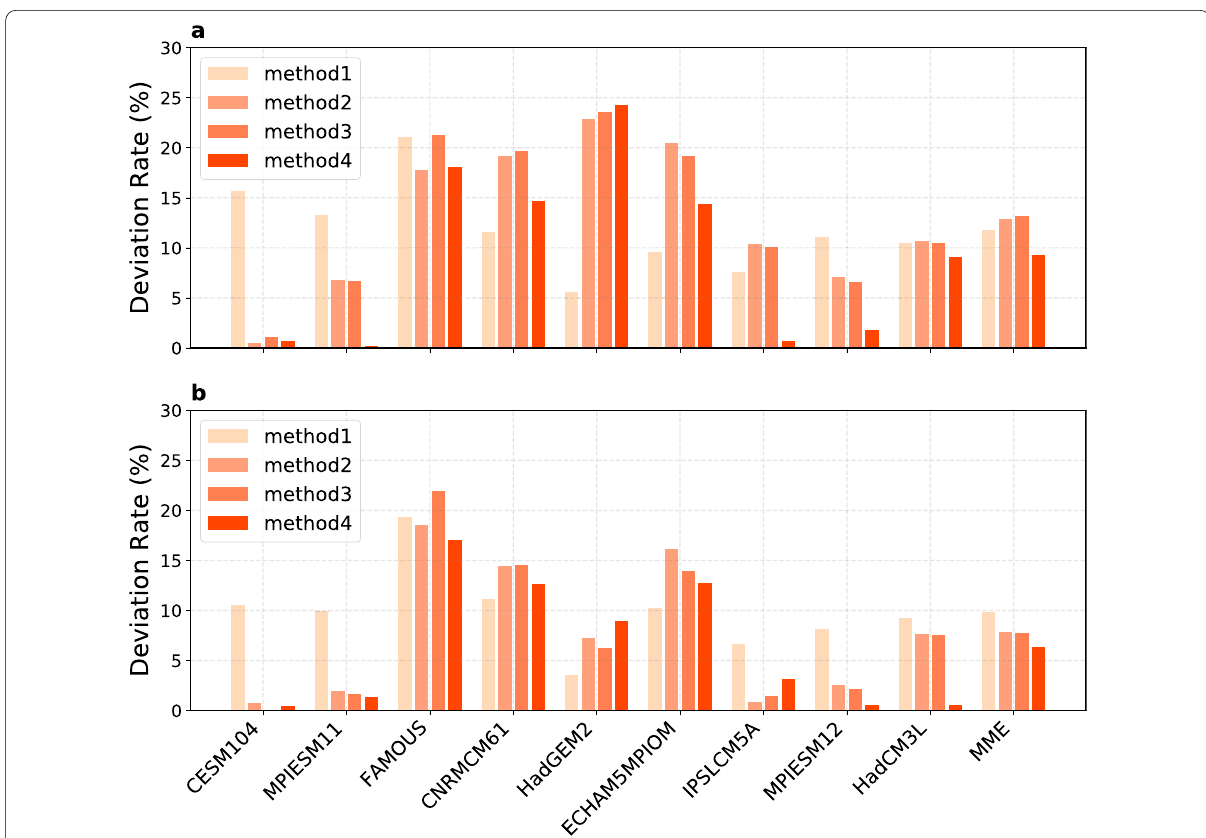
Fig. 5 Deviation rate of the ECS estimated by four methods within limited simulations from the whole simulation in LongRunMIP models: a simulation time-limit of 150 years; b simulation time-limit of 200